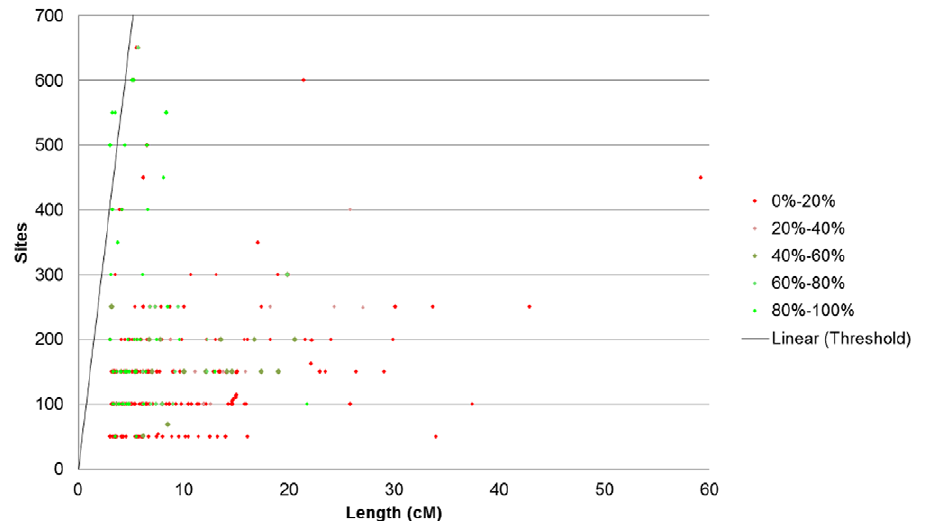
Figure 5. Exome specificity with varying sites and segment length. Exome specificity as a function of both with varying site frequency and segment length. Using specificity data generated for the 50 bit size data seen, we examine here the relationship between the specificity and the site density. Areas of high specificity (color coded green) are concentrated in the portion of the graph where segments demonstrate site density, with high site frequency and low length. Based on the figure, a qualitative observation can be made about how increased site density correlates with increased specificity.